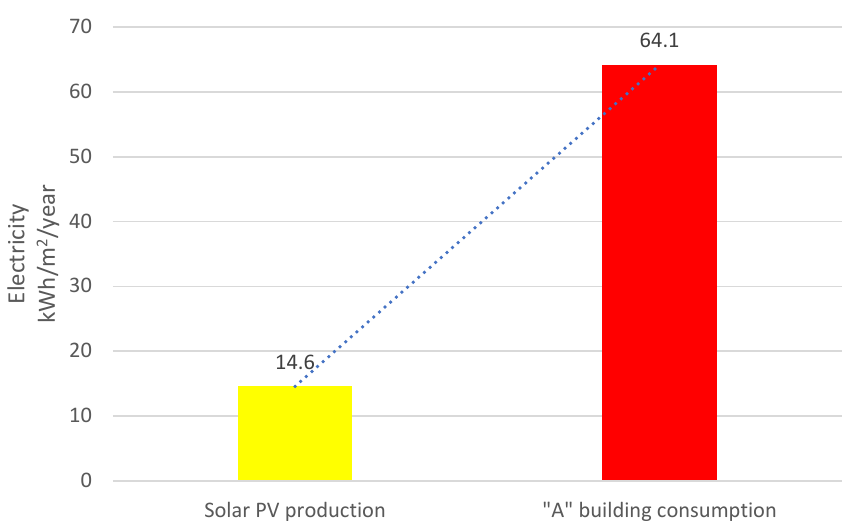
Figure 15. Electricity consumption comparison.